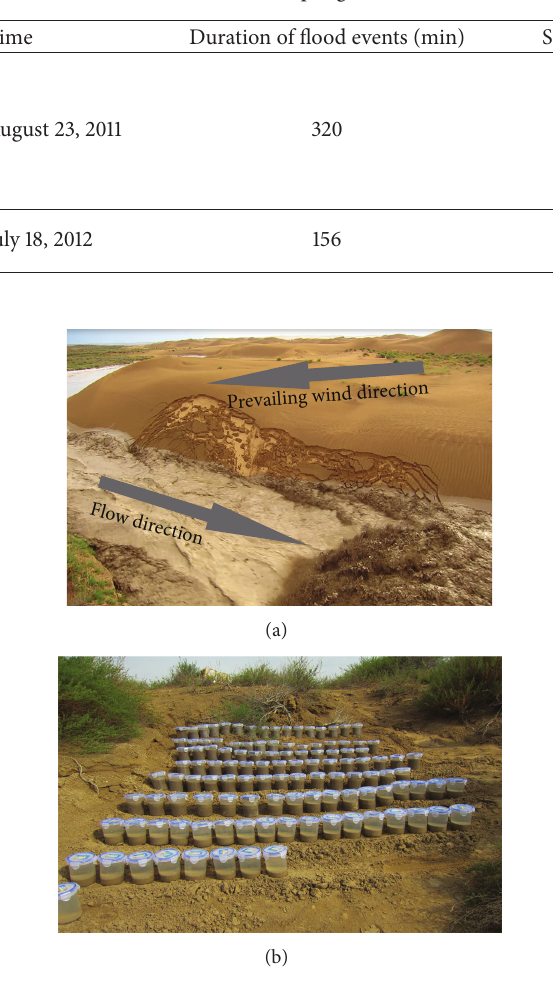
Figure 3: Flash flood event in the Sudalaer desert stream on August 23, 2011 (a), and suspended sediment samples are stored in plastic bottle (b).